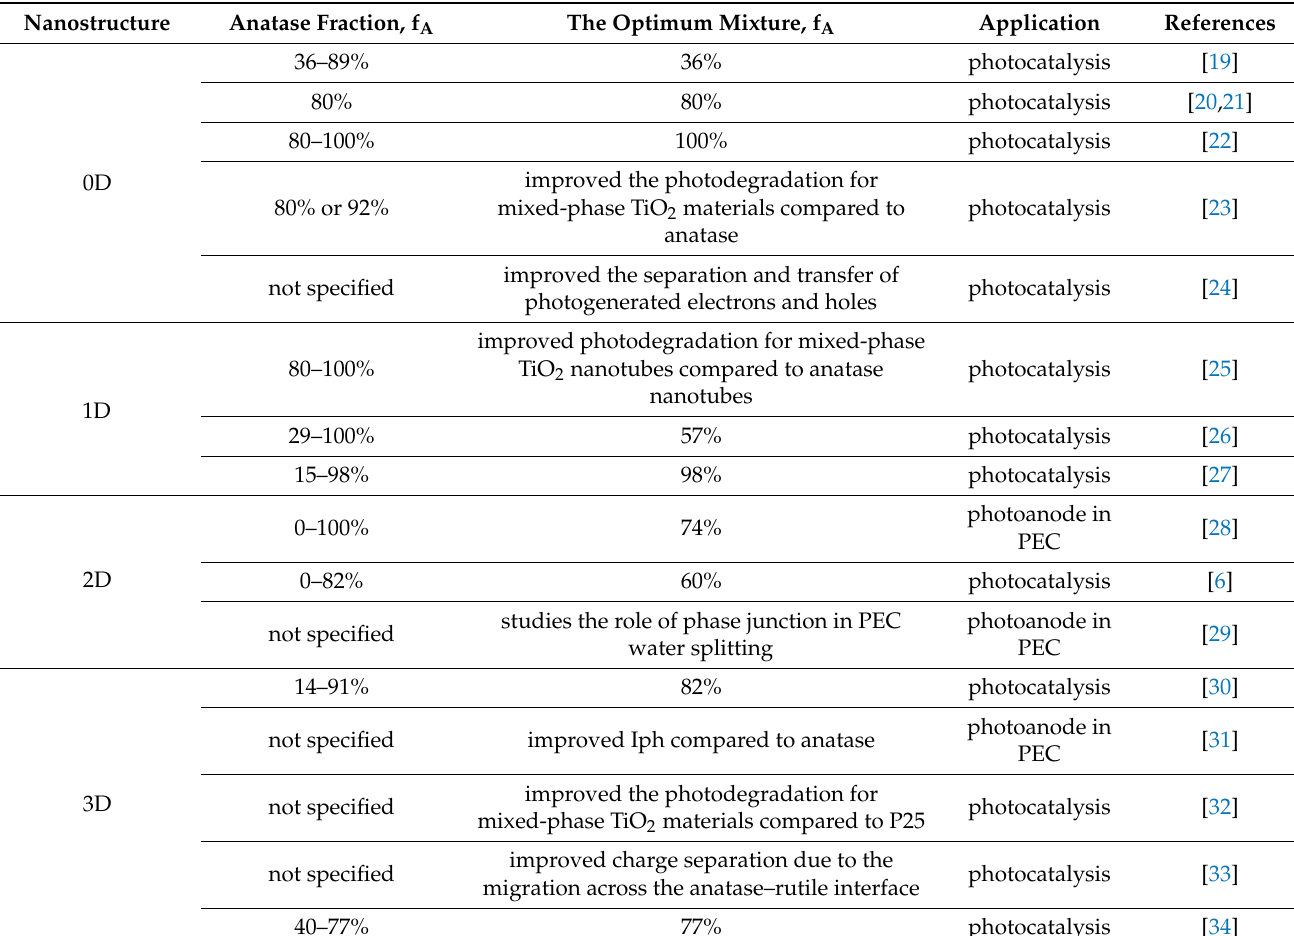
Table 1. TiO 2 -based nanostructures with different contributions of anatase-to-rutile.